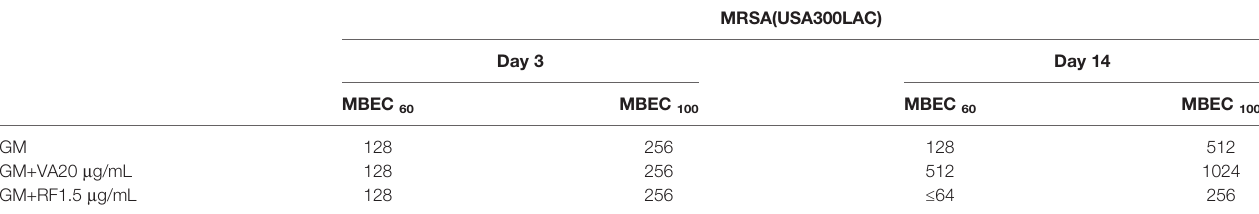
TABLE 5 | Additional effect of second antibiotics in systemic dose on in vivo MBEC of GM.